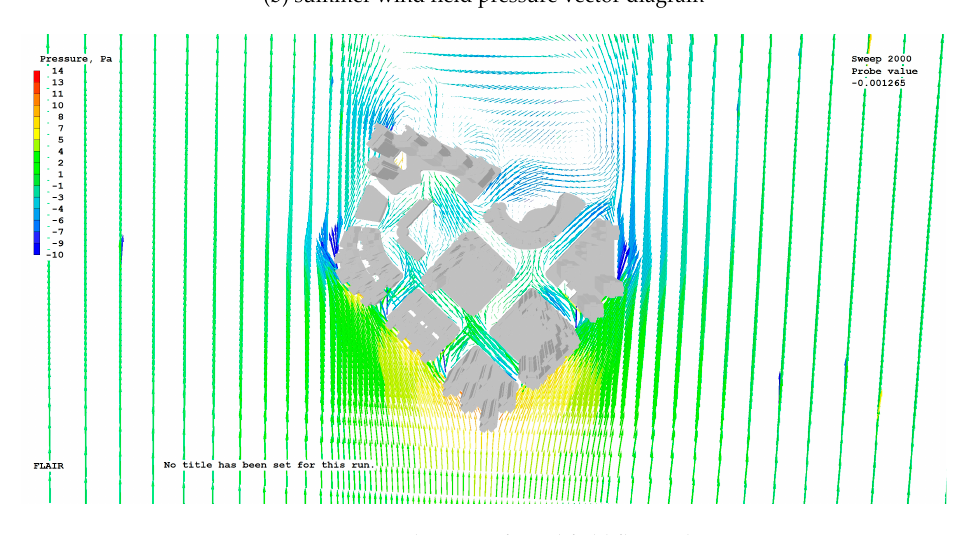
Figure A1. Summer vector diagram, summer wind field pressure vector diagram, and summer vector diagram of wind field flow velocity at 1.5 m height.